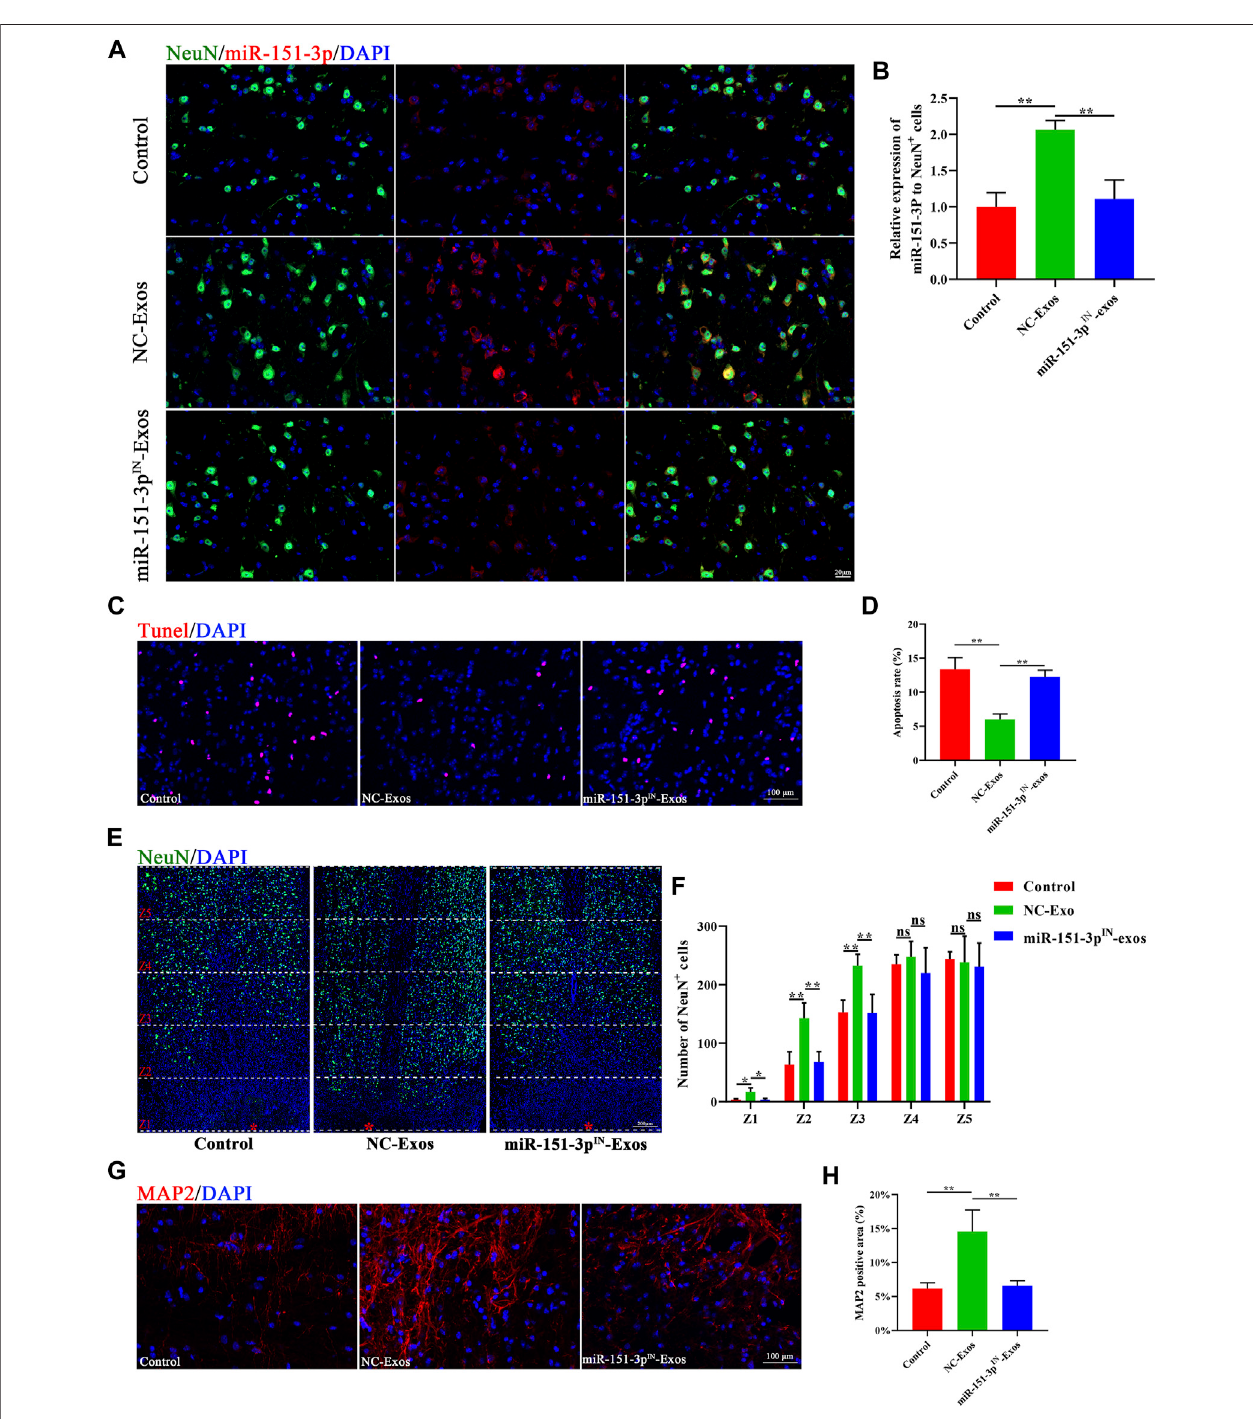
FIGURE 7 | Exosomal miR-151-3p mediate the neuro-protective effects of microglia-Exos on SCI. (A) In situ hybridization of miR-151-3p (red) and fl uorescence staining of NeuN (green) of control, Microglia-Exos, and miR-151-3p IN - Exo – treated groups at the lesion site 3 days post-SCI. Scale bar: 20 μ m. (B) Quanti fi cation of relative expression of miR-151-3p to NeuN + cells in (E). N (cid:1) 3 per group. (C) Representative images of TUNEL staining of control, microglia-exosomes, and miR-151- 3p IN -Exo – treatedgroups.Scalebar:100 μ m. (D) Quanti fi cationoftheapoptosisratein (C) .N (cid:1) 4pergroup. (E) Representative stainingimagesofNeuN(green)of control,microglia-Exos,andmiR-151-3p IN -Exo – treatedgroupsatdifferentzones.Theredstarindicatesthecenteroftheinjurysite.Scalebar:200 μ m. (F) Quanti fi cation of number of NeuN-positive cells at different zones in (E) . N (cid:1) 4 per group. (G) Representative staining images of MAP2 (red) of control, microglia-Exos, and miR-151- 3p IN -Exo – treated groups. Scale bar: 100 μ m. (H) Quanti fi cation of the MAP2-positive area in (G) . N (cid:1) 4 per group. Data are presented as the mean ± SD. * p < 0.05, ** p < 0.01, ns (cid:1) not signi fi cant.